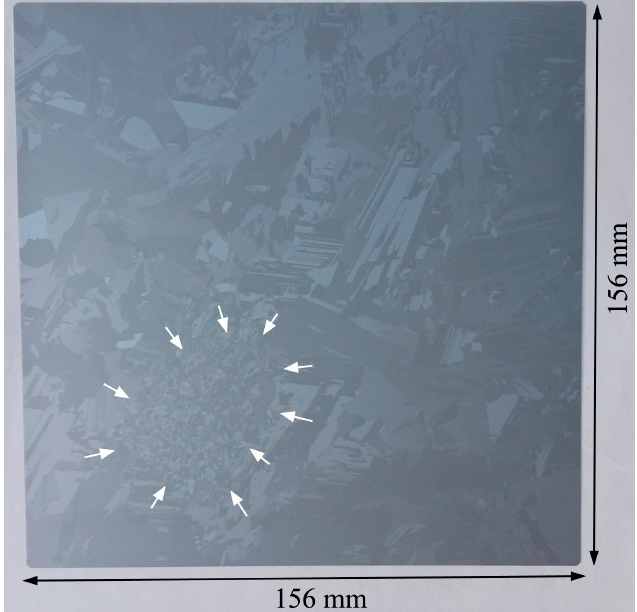
Figure 1. Photograph of a multicrystalline silicon (mc-Si) wafer (156 mm × 156 mm) containing a minicrystallized region (indicated by the white arrows).